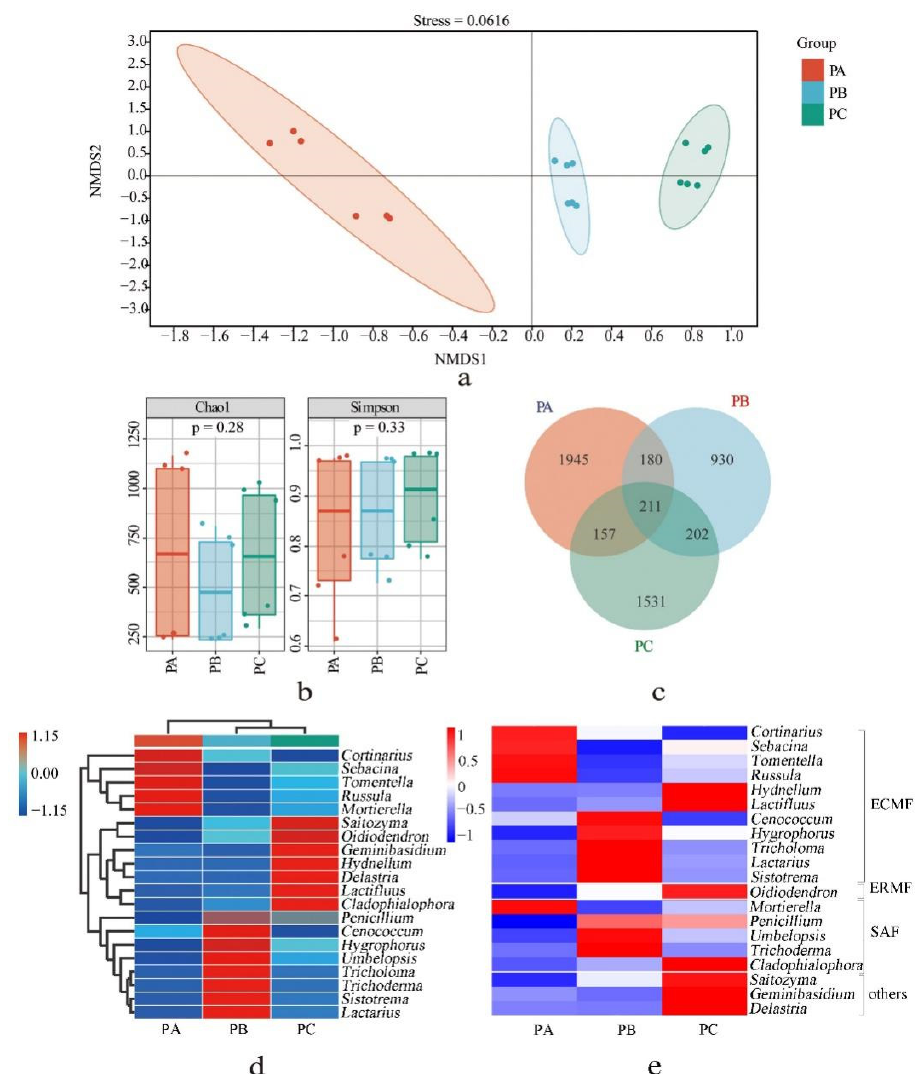
Figure 2. Fungal community in the soil from three collection sites: ( a ) NMDS analysis of fungal beta diversity, ( b ) alpha diversity of fungi, ( c ) Venn map of fungi from three soil samples, ( d ) a heat map of the fungi composition of the first 20 genera. ( e ) Functional guild cluster diagram of fungi of the first 20 genera. ECMF: ectomycorrhizal fungi; ERMF, ericoid mycorrhizal fungi; SAF, saprotrophic fungi. PA, soil sample from plot A; PB, soil sample from plot B; PC, soil sample from plot